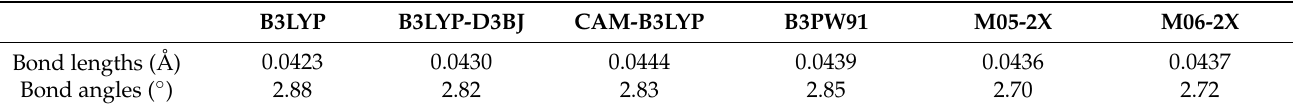
Table 1. Mean absolute errors for the bond lengths and angles for structures optimized with various functionals in conjunction with 6-31++G(d,p) level of theory.